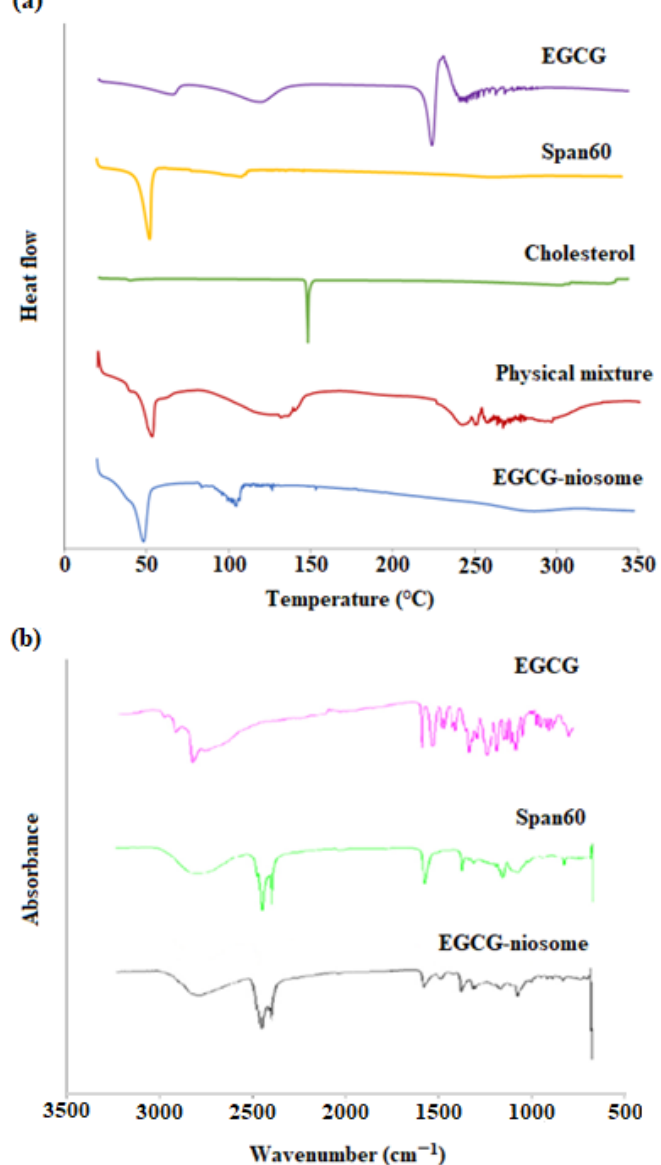
Figure 3. ( a ) Differential Scanning Calorimetry (DSC) thermograms and ( b ) Fourier Transform In- fra-red Spectroscopy (FTIR) spectra of EGCG, Span 60 and EGCG-niosomes.